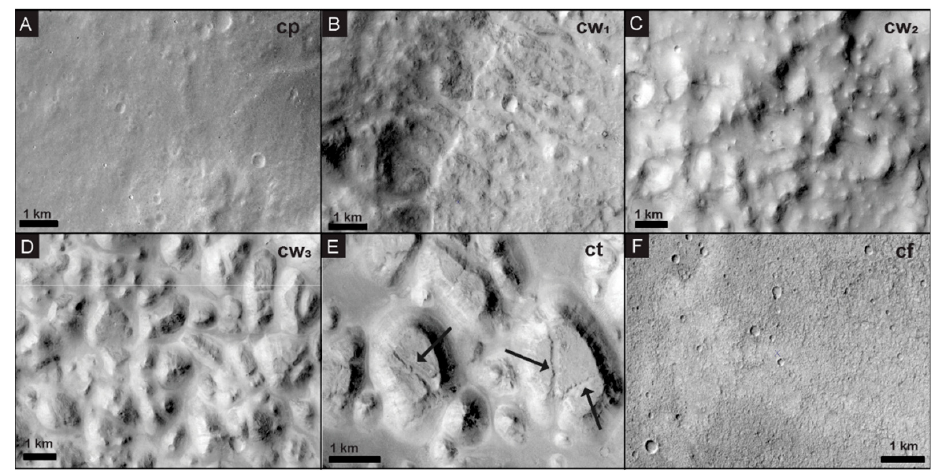
Figure 4. Example images of the geomorphic units mapped in Figure 3. ( A ) Cratered plains (cp) that surround Galilaei crater host eroded craters and low-relief topography. ( B ) The smooth crater wall (cw 1 ) subunit dominates the northern and western crater rim and is incised by small channels. ( C ) the chaotic crater wall (cw 2 ) subunit exhibits sub-kilometer-scale rounded knobs similar to highly eroded chaos terrain. ( D ) The highly chaotic crater wall (cw 3 ) subunit includes flat-topped blocks similar to small chaos blocks observed further into the crater basin. ( E ) Chaos terrain (ct), the focus of this work, is defined by irregularly shaped, often flat-topped, blocks and knobs. In some cases, fractures show where the flat-topped block has broken apart (arrows). ( F ) The crater floor (cf) hosts many small craters with slightly sharper rims than seen on the surrounding plains. Topography on the crater floor is limited. All images are contrast-stretched CTX. See Figure 3 for image locations.